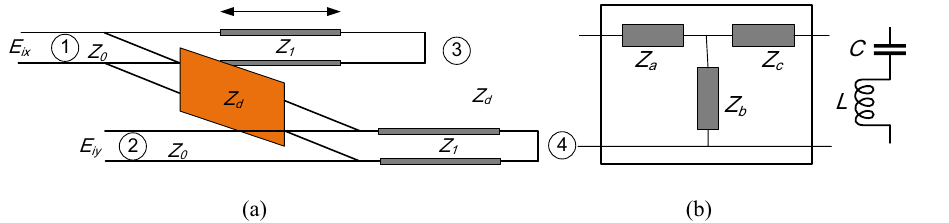
Figure 8. ( a ) The equivalent circuit of the unit cell in Fig. 1. ( b ) T-type of the canonical topology of the two- port interconnection network,